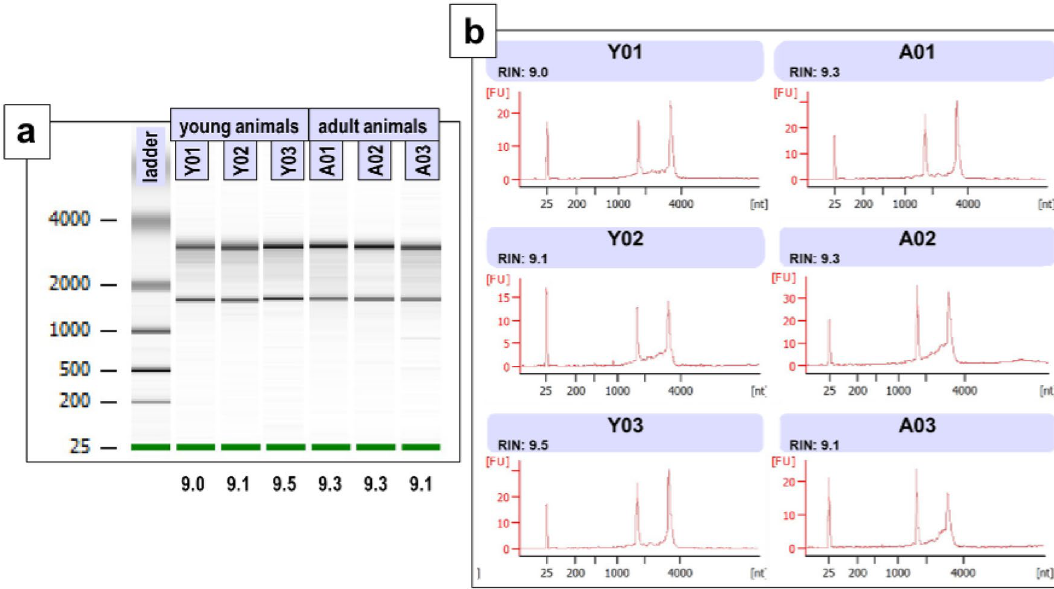
Figure 1. RNA integrity. Gel images ( a ) and electropherograms ( b ) of three representative blood RNA samples in each age group and the RIN values (under the green lines) obtained with the 2100 Bioanalyzer (Agilent). RIN = RNA Integrity Number. Green lines = Bioanalyzer internal